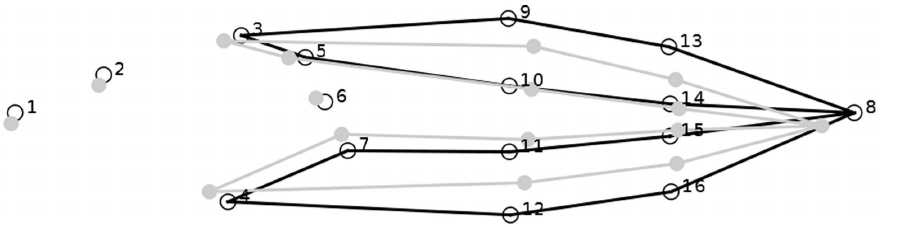
Figure 1. Wireframe drawing of shape change (grey line) against average tadpole shape (black line) described by an increase in the first principal component (PC1) of a Principal Components Analysis (PCA) for all weeks combined using the aquarium averages of sixteen landmarks.